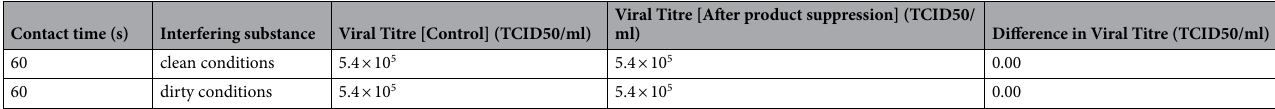
Table 3. Suppression of product virucidal